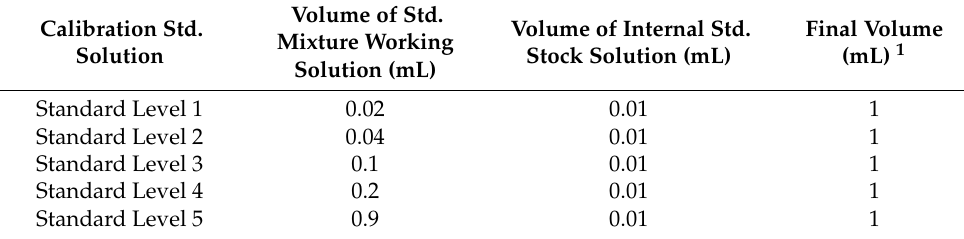
Table 1. An example of making final calibration standard solutions with GS9, GS10, GS11, and IS. Volume of Calibration Std.